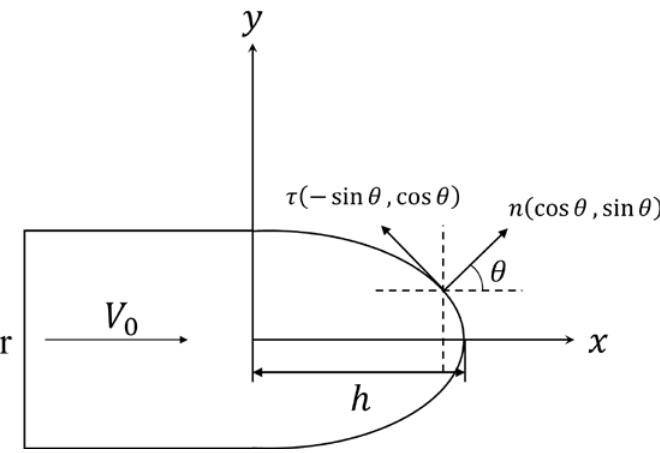
Figure 10. The typically projectile nose shape.